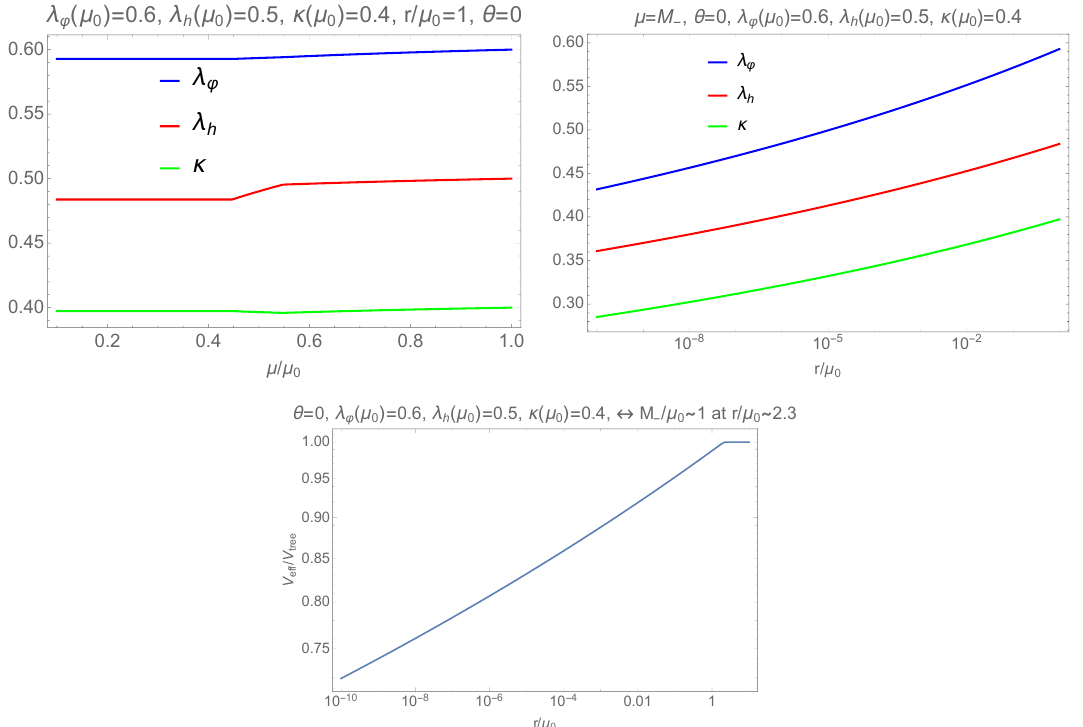
Figure 5 . Upper Left: the running coupling constants as functions of (cid:22) for (cid:18) = 0. Upper Right: the running coupling constants as a function of r where we put ~ (cid:22) = min( M the e(cid:11)ective potential for (cid:18) = 0 as a function of r . In the upper left panel of (cid:12)gure 5, we show the running couplings obtained from eqs. (3.17){(3.19) in the direction (cid:18) = 0. Here, all the dimensional quantities are normalized by the initial value of the initial renormalization scale (cid:22)